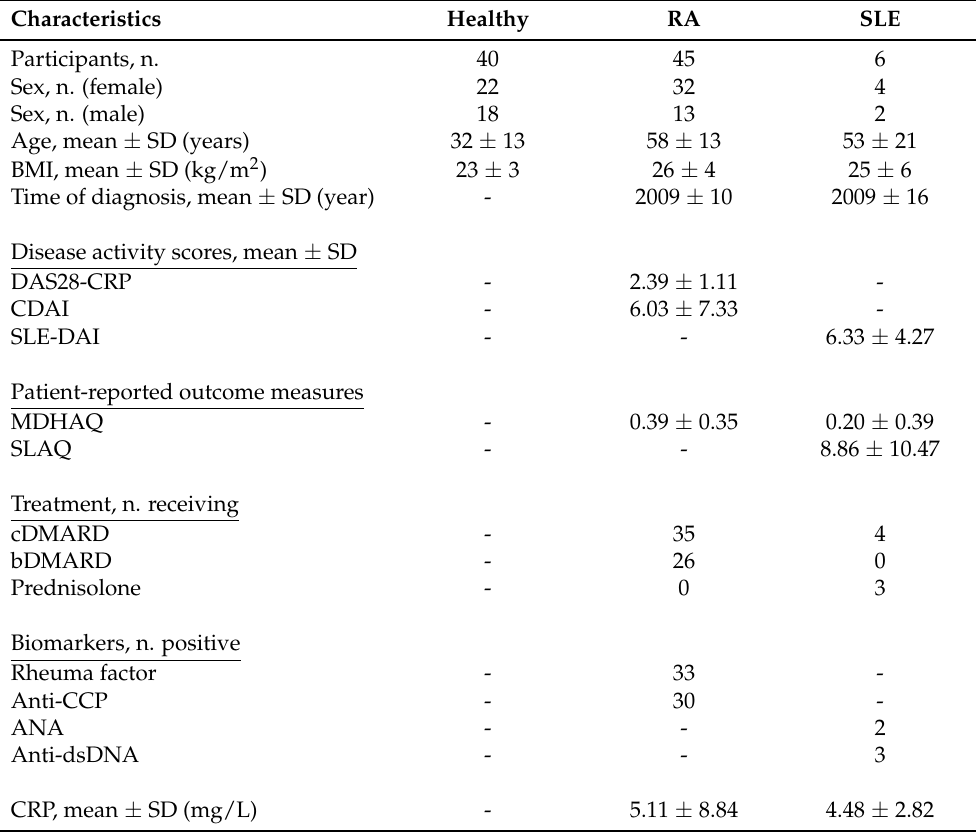
Table 2. Participant characteristics. RA: Rheumatoid Arthritis. SLE: Systemic Lupus Erythematosus. n: Number. SD: Standard deviation. BMI: Body mass index. DAS28-CRP: Disease Activity